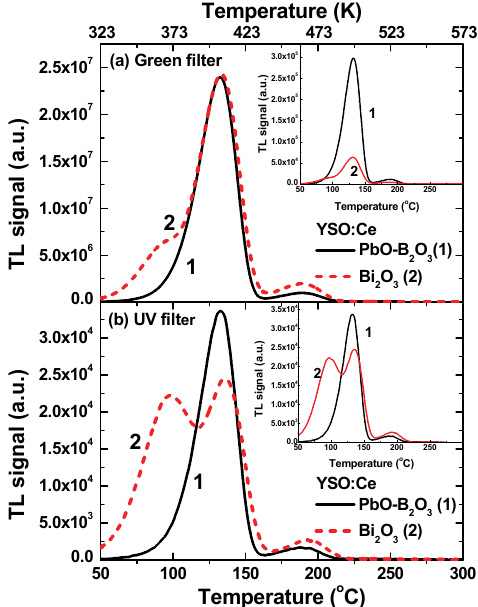
Figure 5. TL glow curves of YSO:Ce SCFs, grown from PbO (1) and Bi 2 O 3 (2) based fluxes, registered using ( a ) “green” and ( b ) “UV” emission filter. Main graphs show TL glow curves measured after irradiation with alpha particles (3.9 × 10 7 cm − 2 ) and insets show TL glow curves after exposure to beta